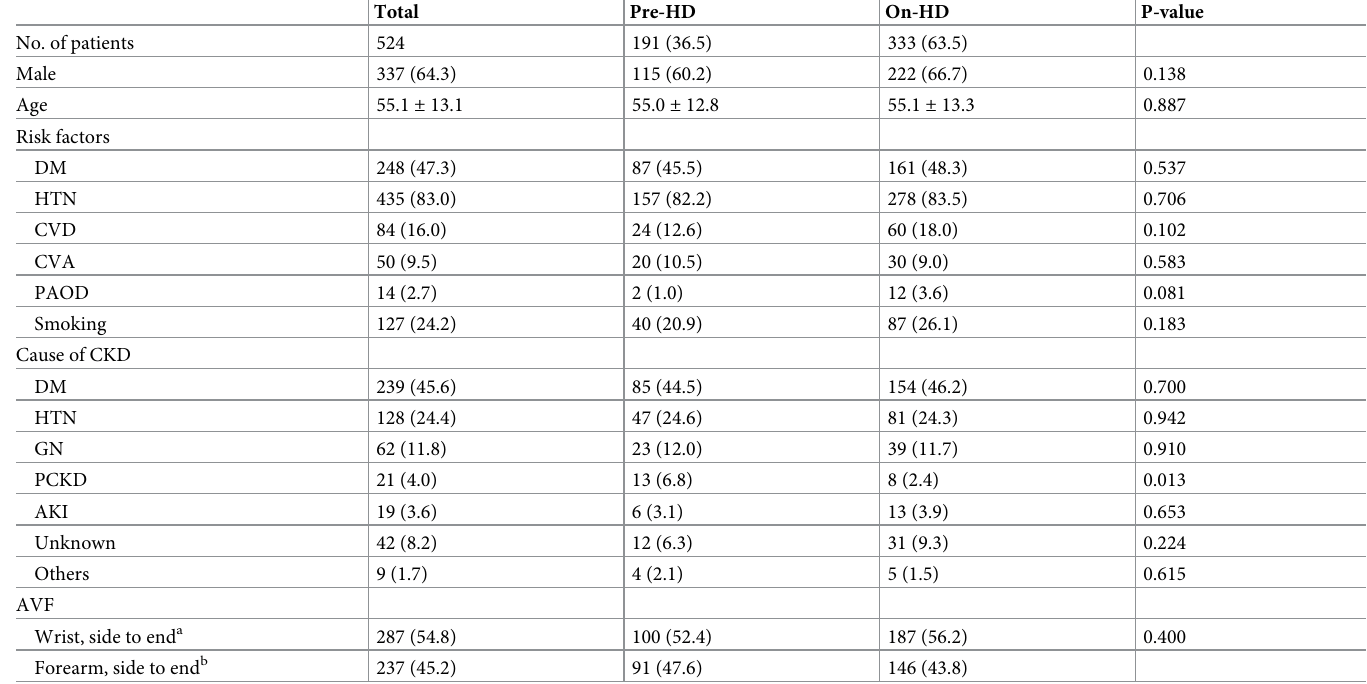
Table 1. Baseline demographic and clinical characteristics of the study population at the onset of CKD (HD initiation) according to the initially created vascular access.